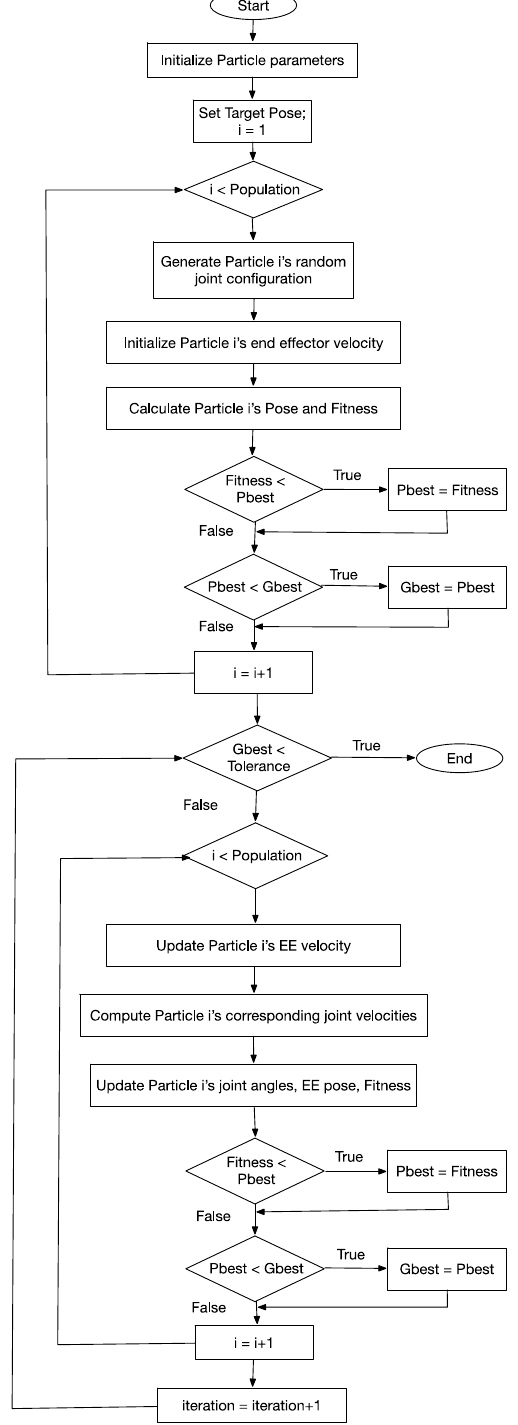
Figure 2. Flowchart of the PSO implementation.